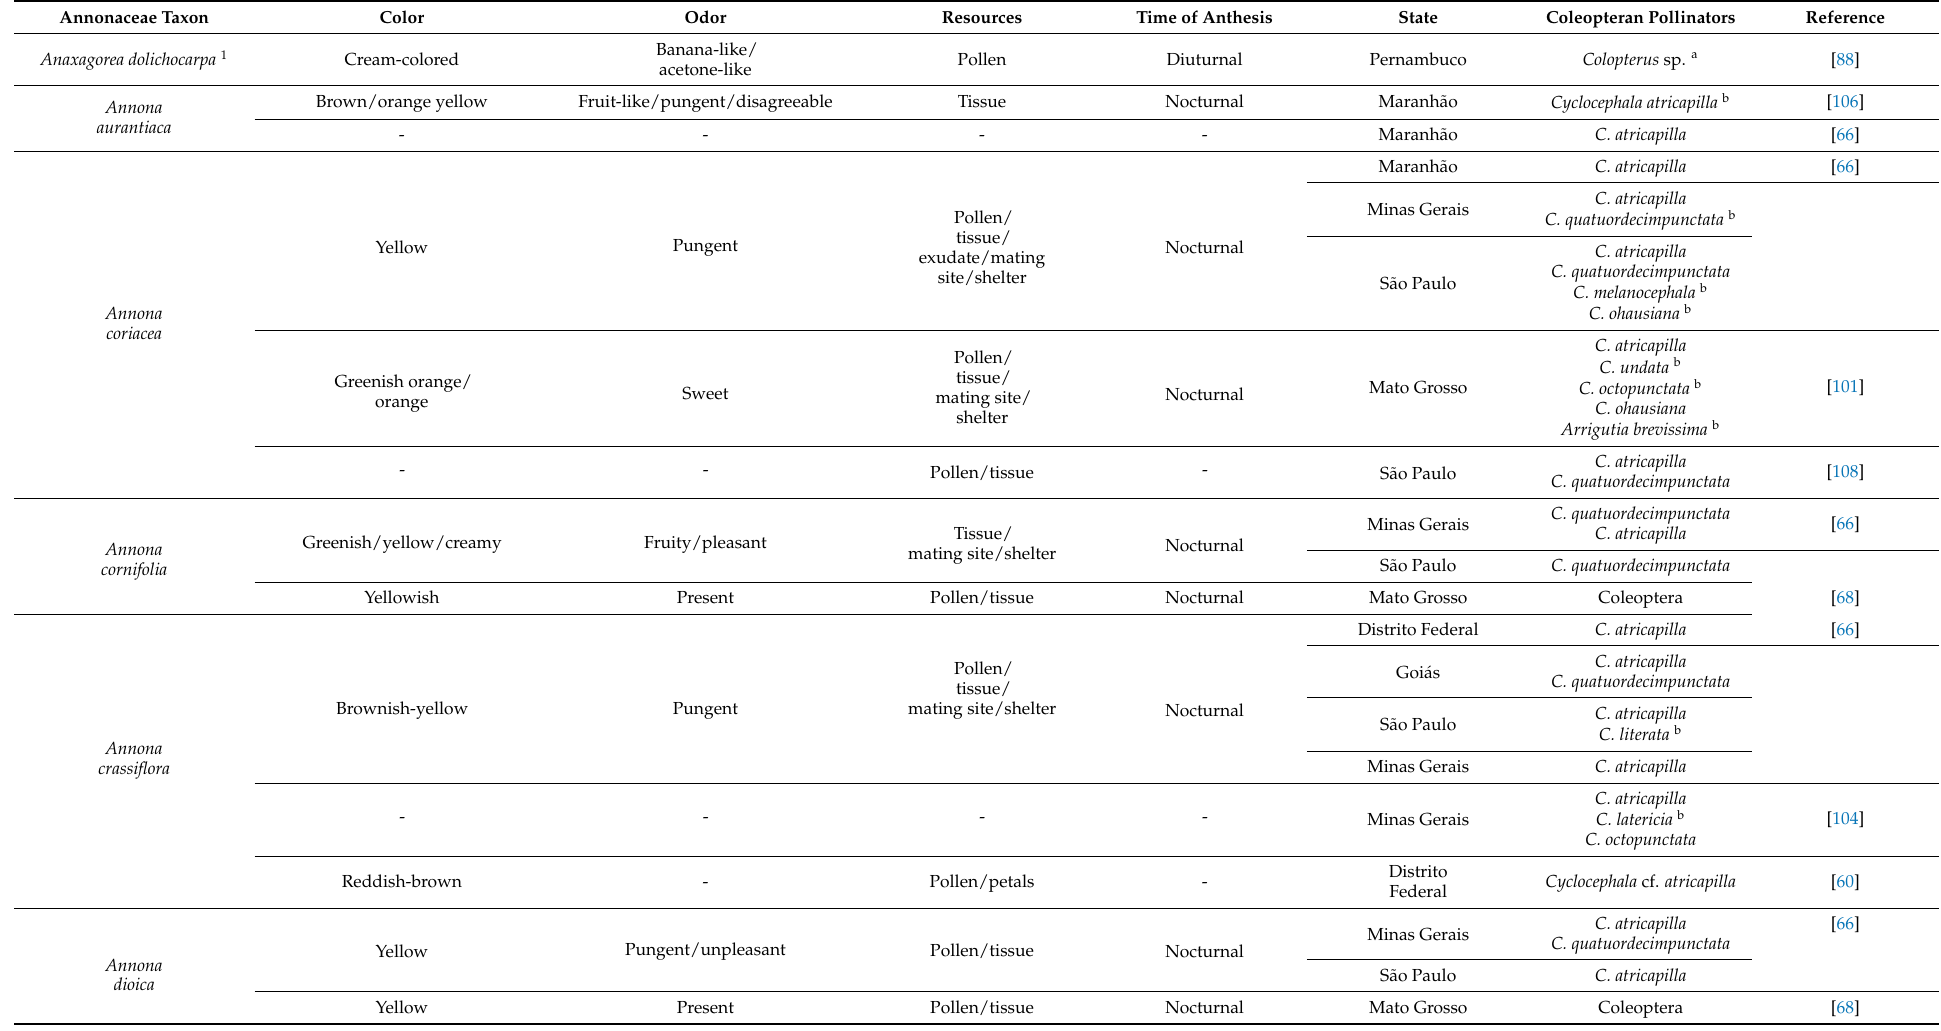
Table 1. Summary of reviewed literature with records of cantharophily in Cerrado